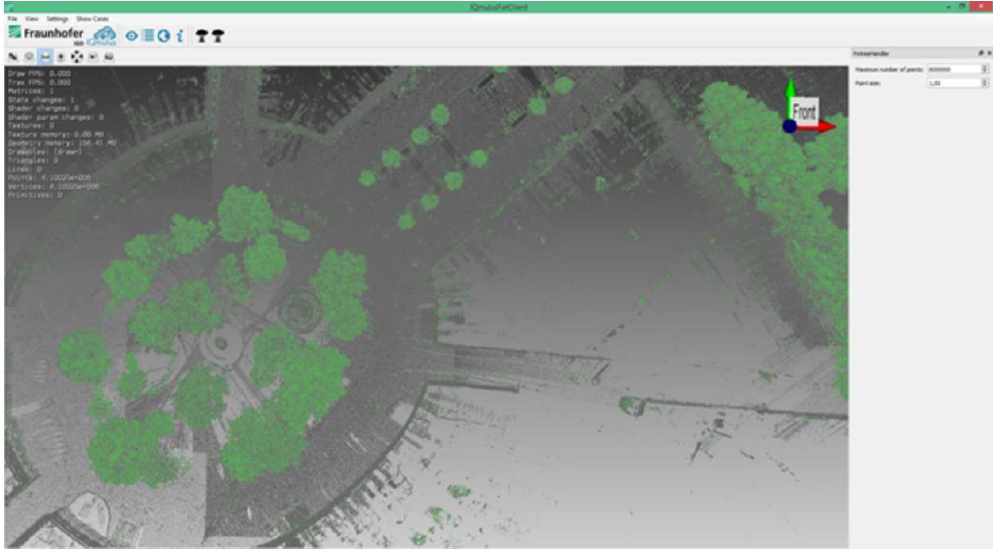
Figure 7. 4000+ tree locations automatically identified by the IQmulus US2 workflow overlaid as KML layer on Google Earth imagery of Toulouse.